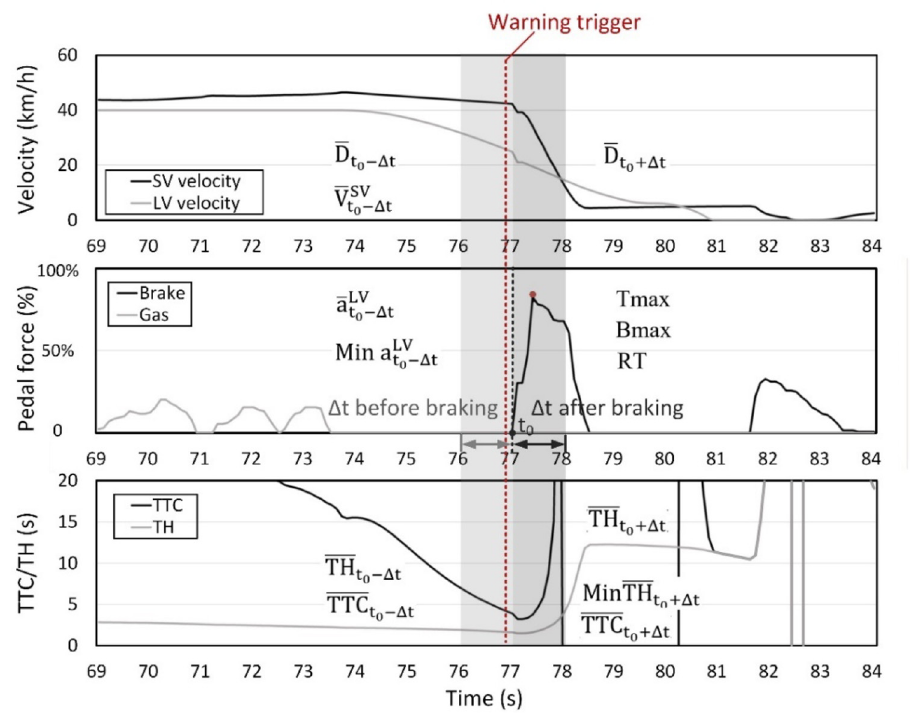
Figure 7 Variables extracted before and after driver ’ s fi rst brake for collision